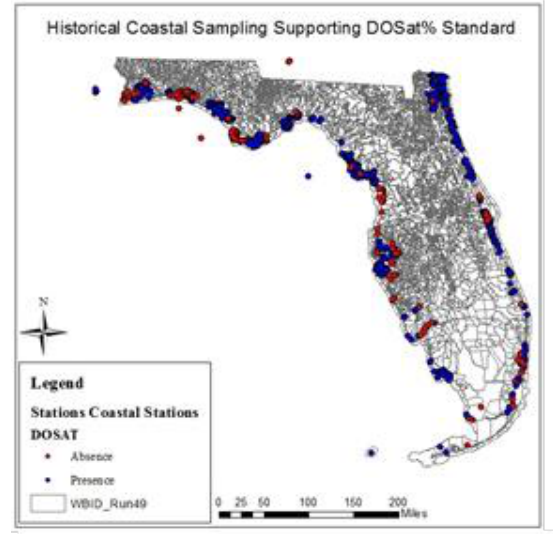
Figure 2. Coastal DO and pDOSAT historical record